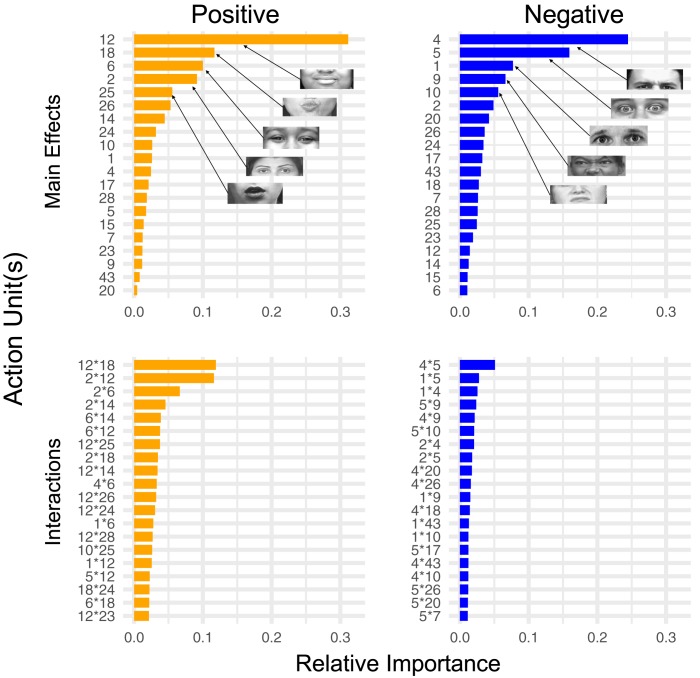
Main and interactive effects among and between AUs for positive and negative ratings.Relative importance of the main effects and interactions among all AUs for positive and negative human-coder ratings. Relative importance (normalized partial dependence from the RF model) is a measure the SD in the outcome variable (i.e. positive or negative affect intensity) attributable to each AU while integrating over all other AUs, and it can be interpreted as how important a given AU is with respect to all other AUs. Note that partial dependence is not directional (see Fig 6 for directional effects). Visual depictions of the 5 most important AUs for predicting positive and negative ratings are shown on the graphs. Because there are 190 possible combinations of AUs for displaying interactive effects, we only show the top 20 here for brevity.